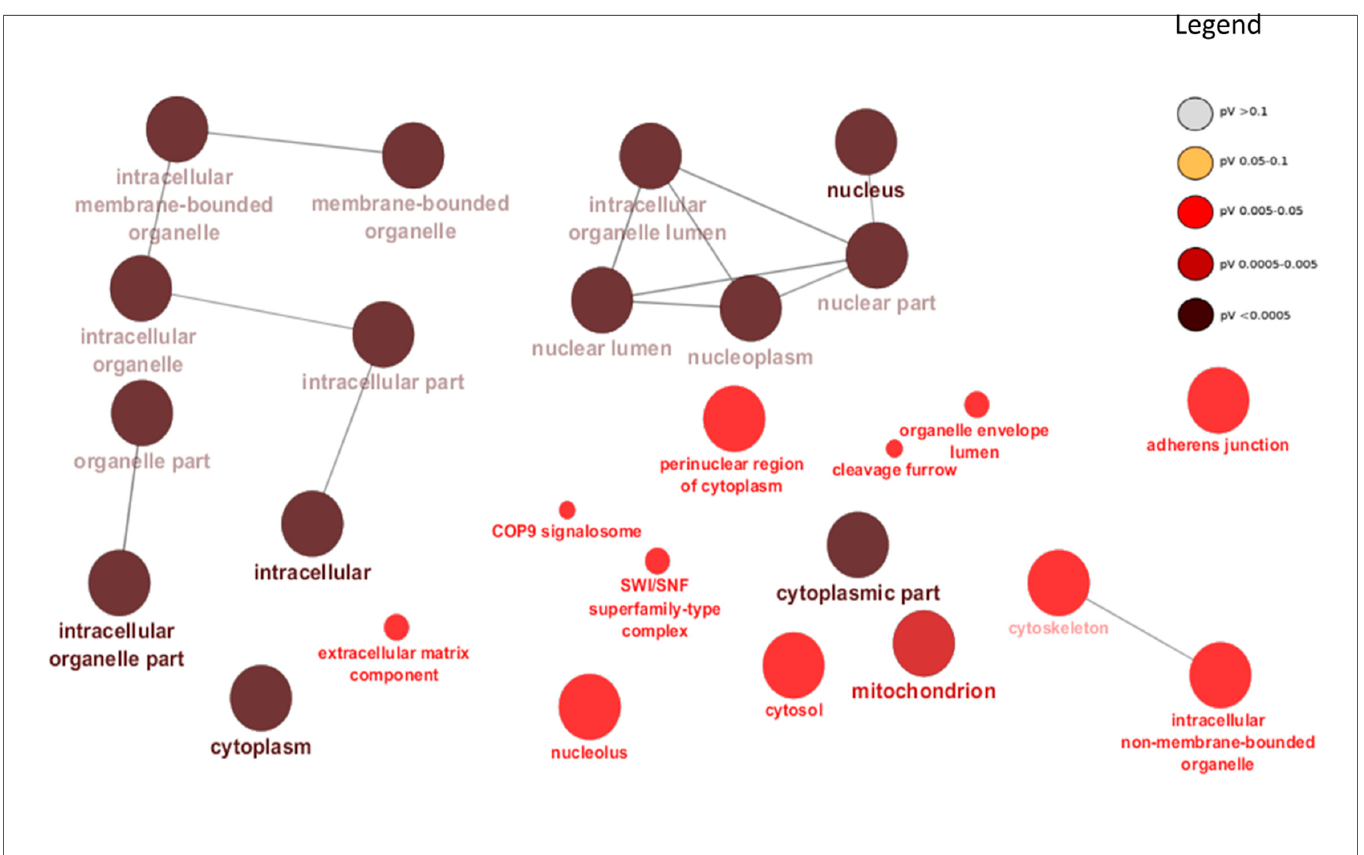
Figure 3. The ClueGO results for cellular processes gene ontology terms enrichment for target genes of differentially expressed miRNAs and relationships between them. The nodes (round shape) represent gene ontology terms, node color represents the level of significance as indicated in the legend, while node size reflects the number of genes enriched in each gene ontology term.